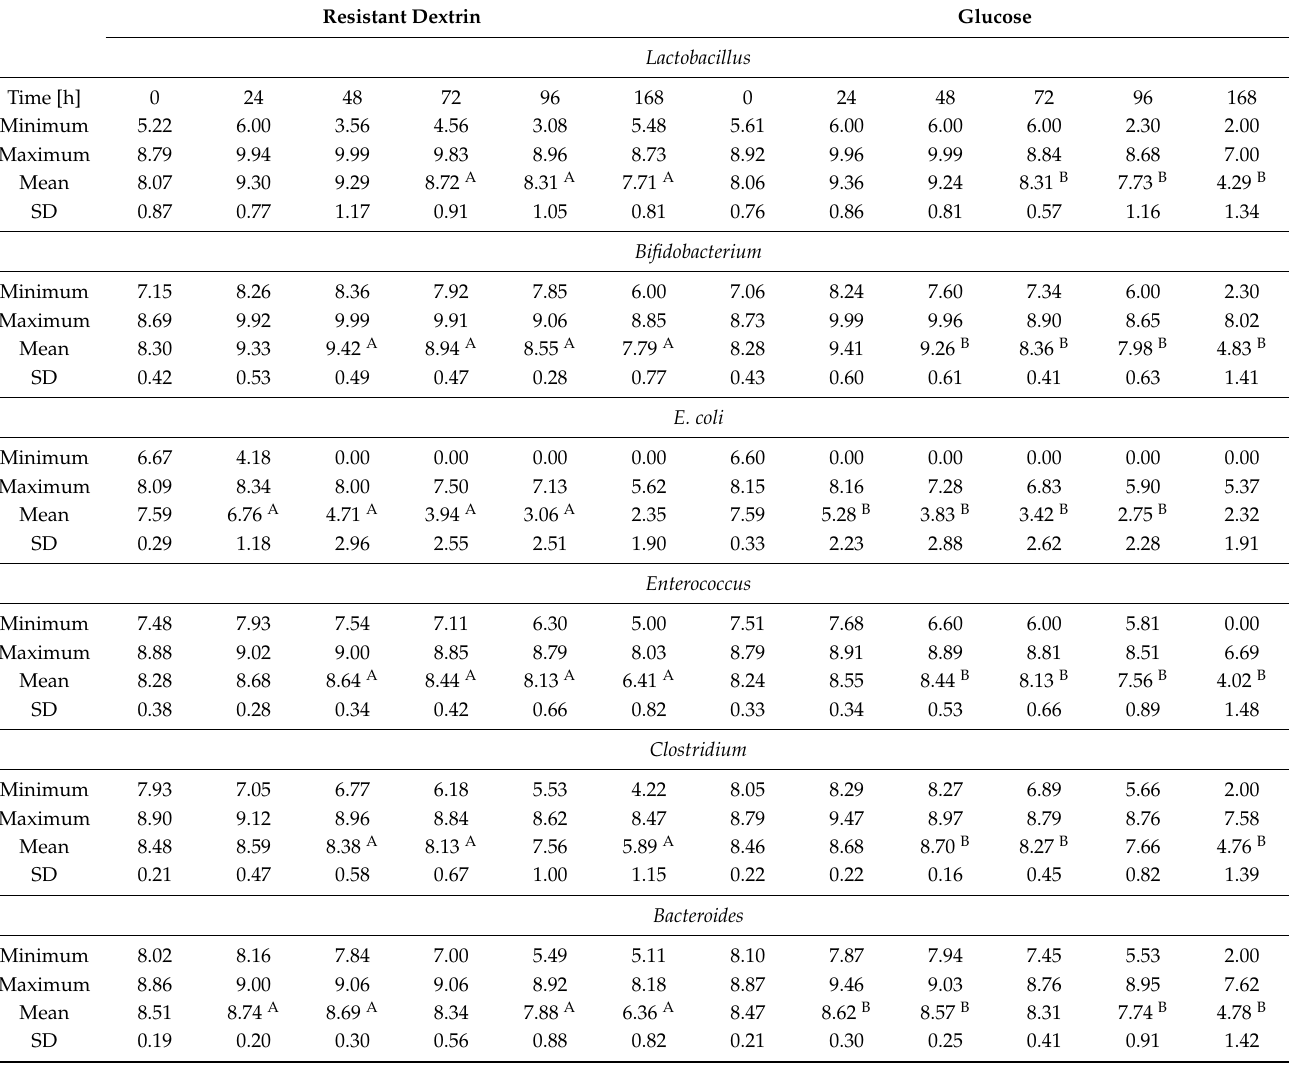
Table 2. Comparison of growth of the intestinal bacteria in the samples cultivated on medium with the resistant dextrin and glucose (control) as a source of carbon. Resistant Dextrin Glucose